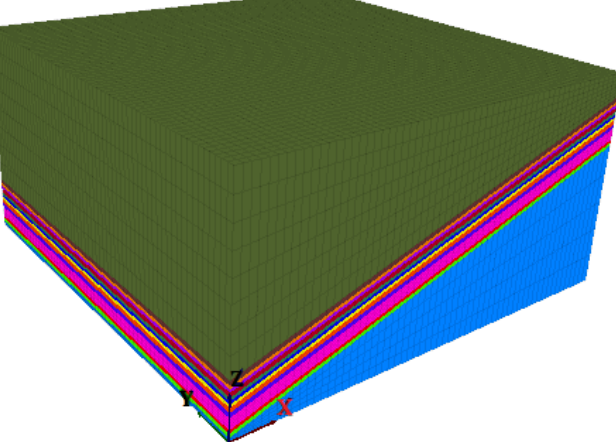
Figure 4. Numerical model schematic.